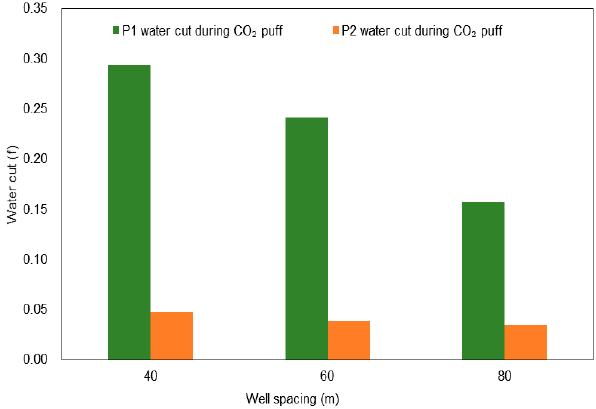
Figure 20. Production water cut after well stuffy.